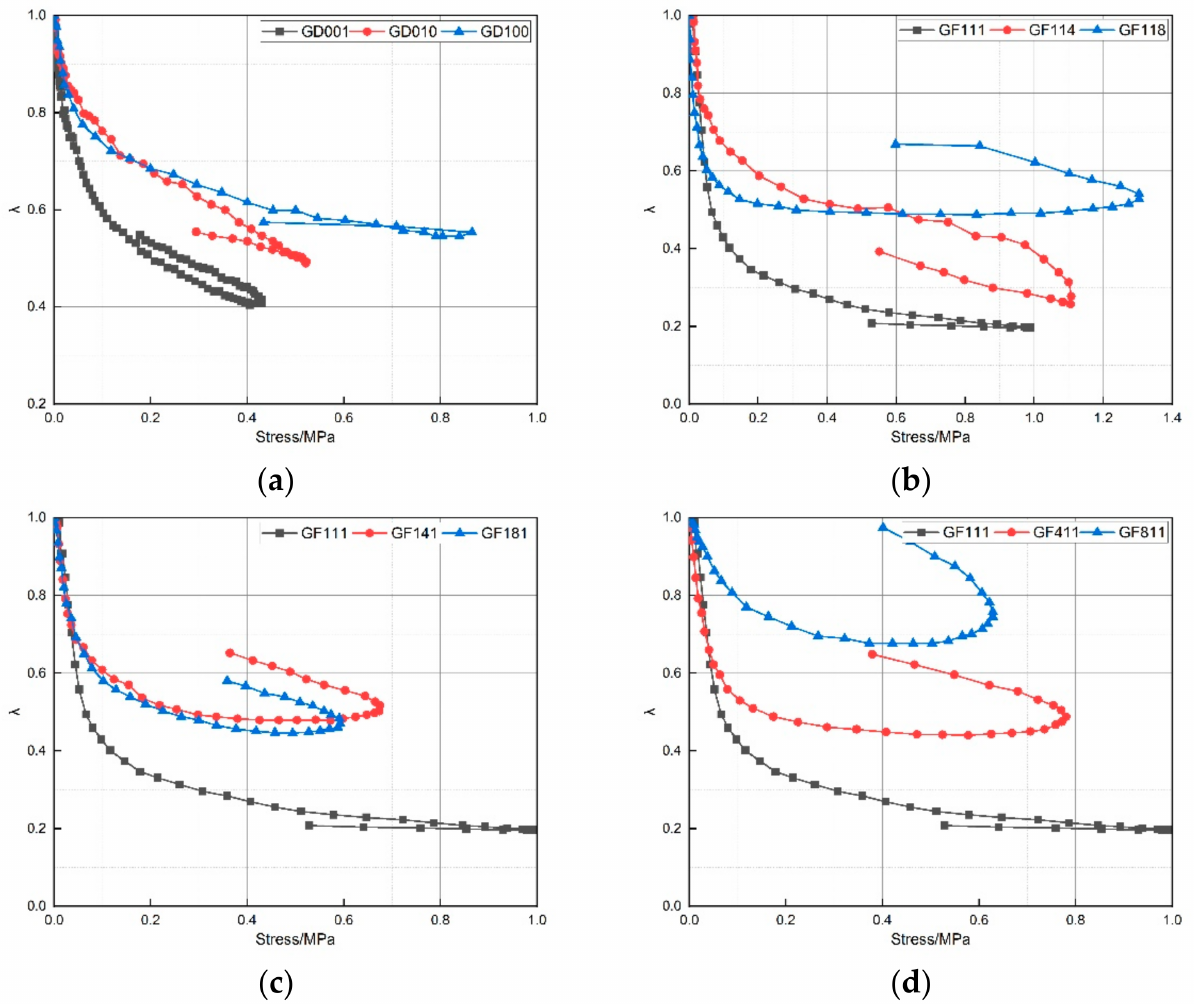
Figure 7. Relative resistivity–stress curves of different tectonic coal samples. ( a ) Relative resistivity curves of GD100, GD010, and GD001 ( b ) Relative resistivity curves of GF111, GF114, and GF118 ( c ) Relative resistivity curves of GF111, GF141, and GF181 ( d ) Relative resistivity curves of GF111, GF411, and